Question: Write a single sentence explaining what this figure depicts.
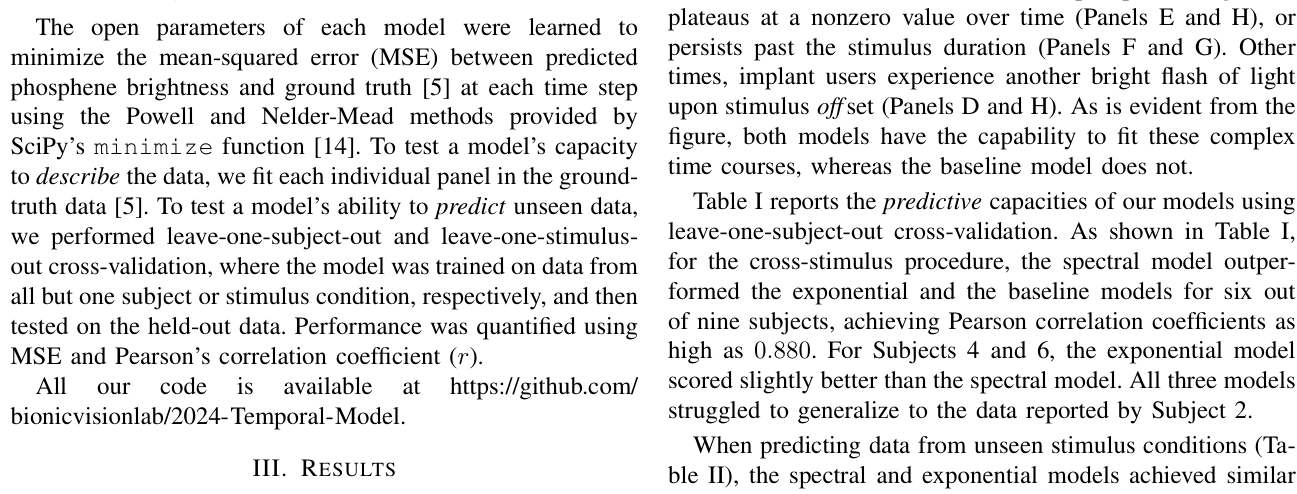
Answer: demonstrates the descriptive capacities of the spectral (m = 4) and exponential models, compared to baseline [10]. Here, each model was individually fit to ten representative time courses of phosphene brightness [5]. Panels A–C represent prototypical examples where brightness continuously fades with repeated stimulation (stimulus duration is indicated with a gray bar on the top of each panel) and then quickly returns to